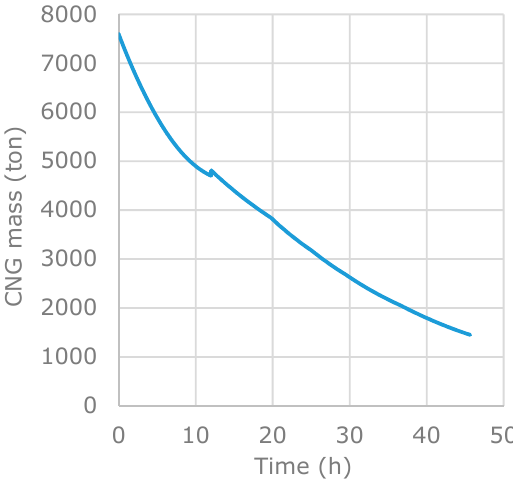
Figure 14. Mass of CNG in the pressure vessels (adiabatic unloading).